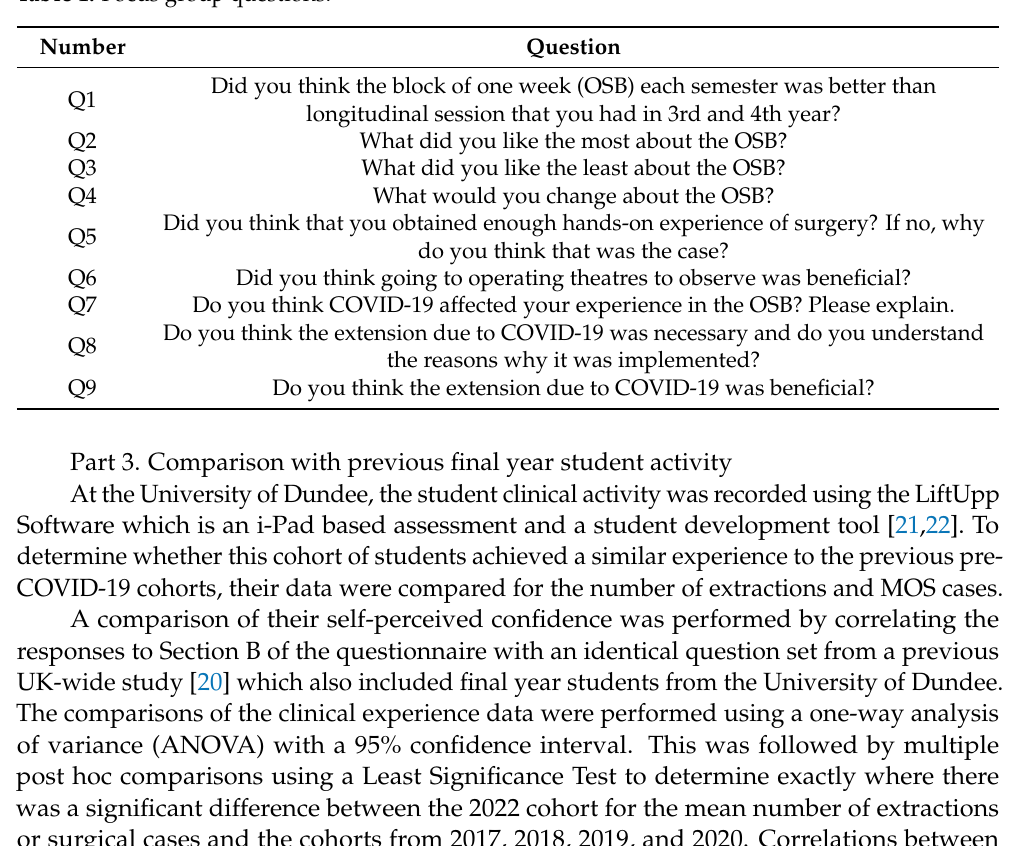
Table 1. Focus group